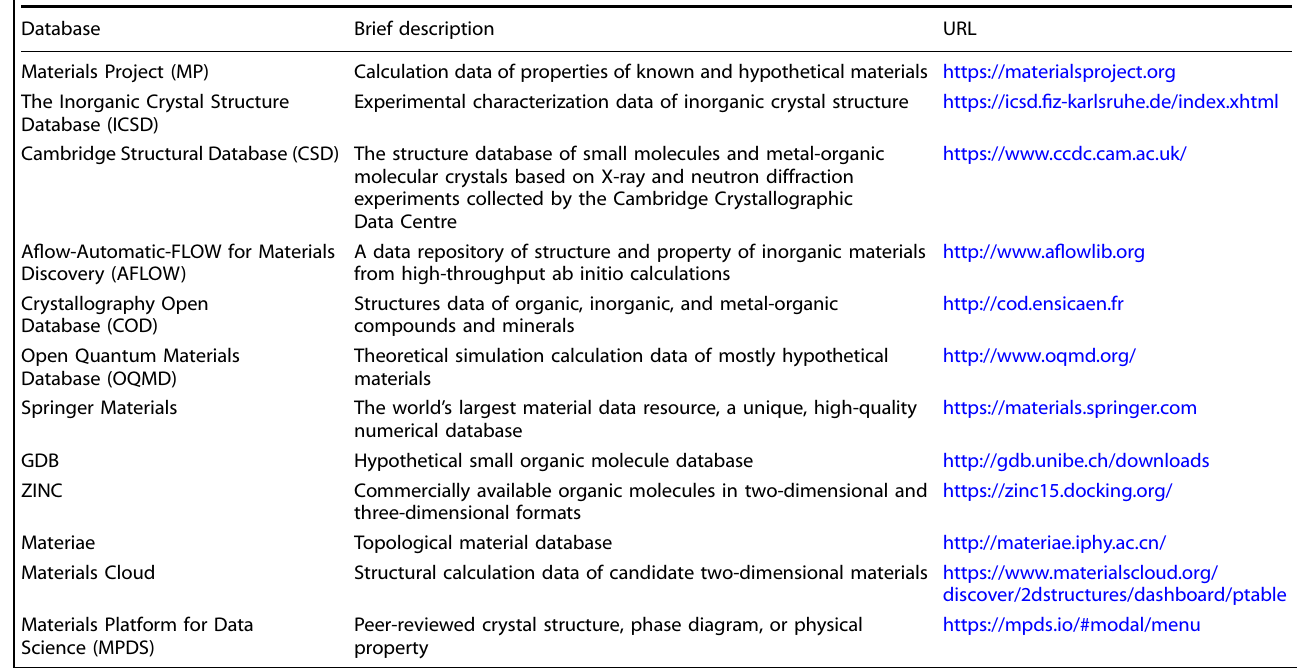
Table 1. Publicly accessible databases of various